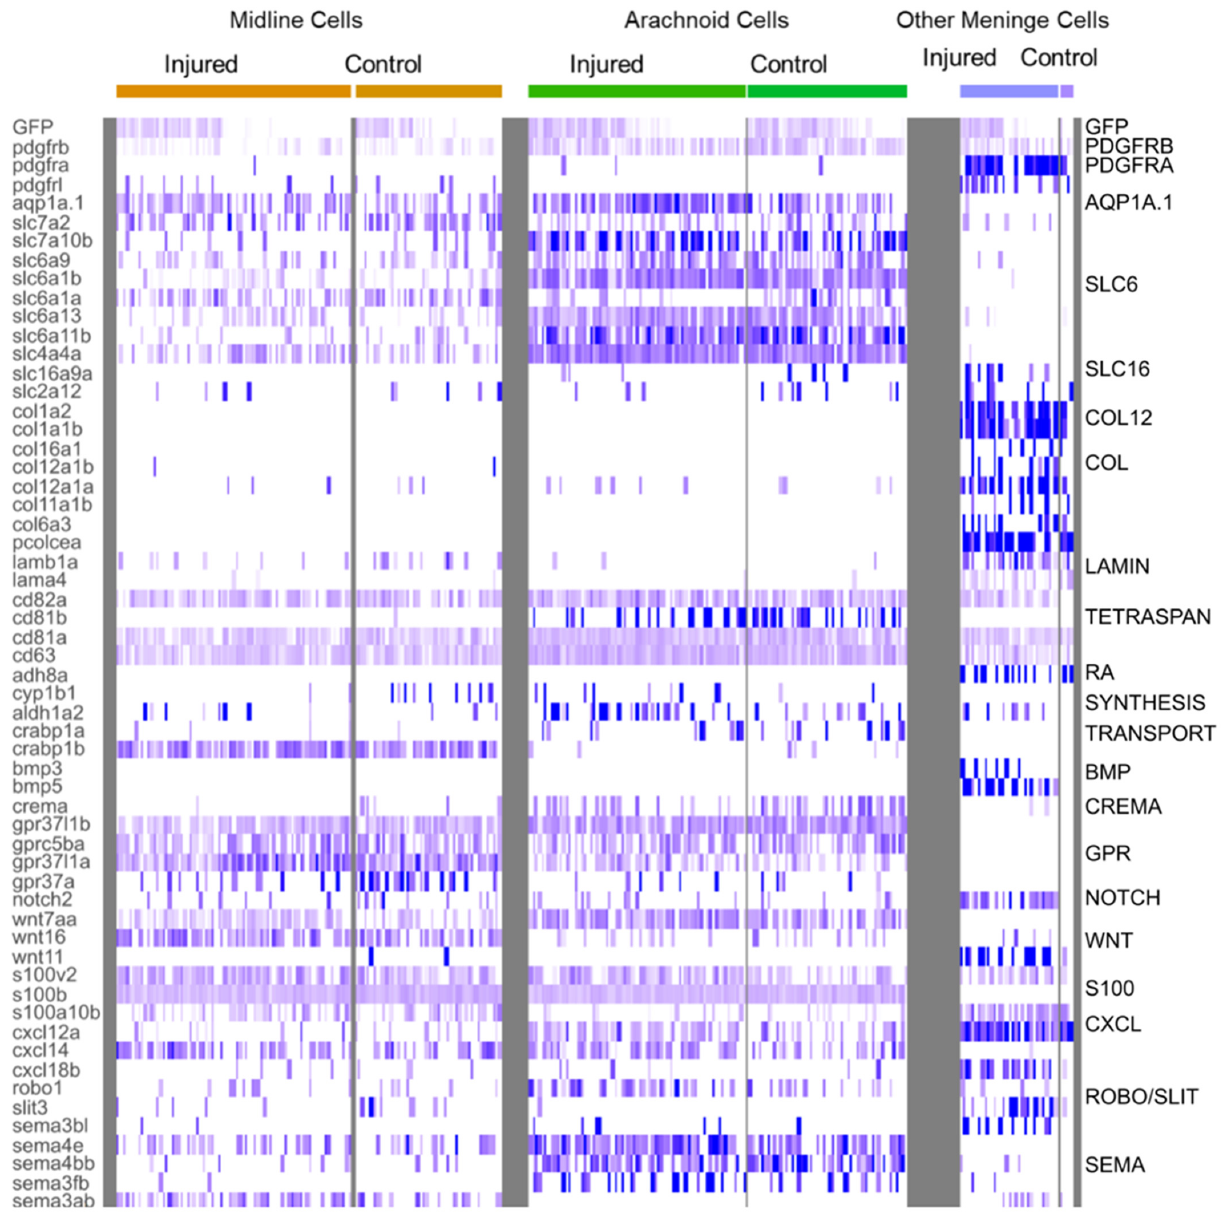
Figure 6. Heatmap of characteristic gene expression levels in MID, ARA and OMN cells from control and injured datasets. Each column represents a cell. Level of expression is encoded by color gradient. Strong expression is in dark blue and no expression is in white. Gene families are represented to the right of the panel in regards to the corresponding DEGs.